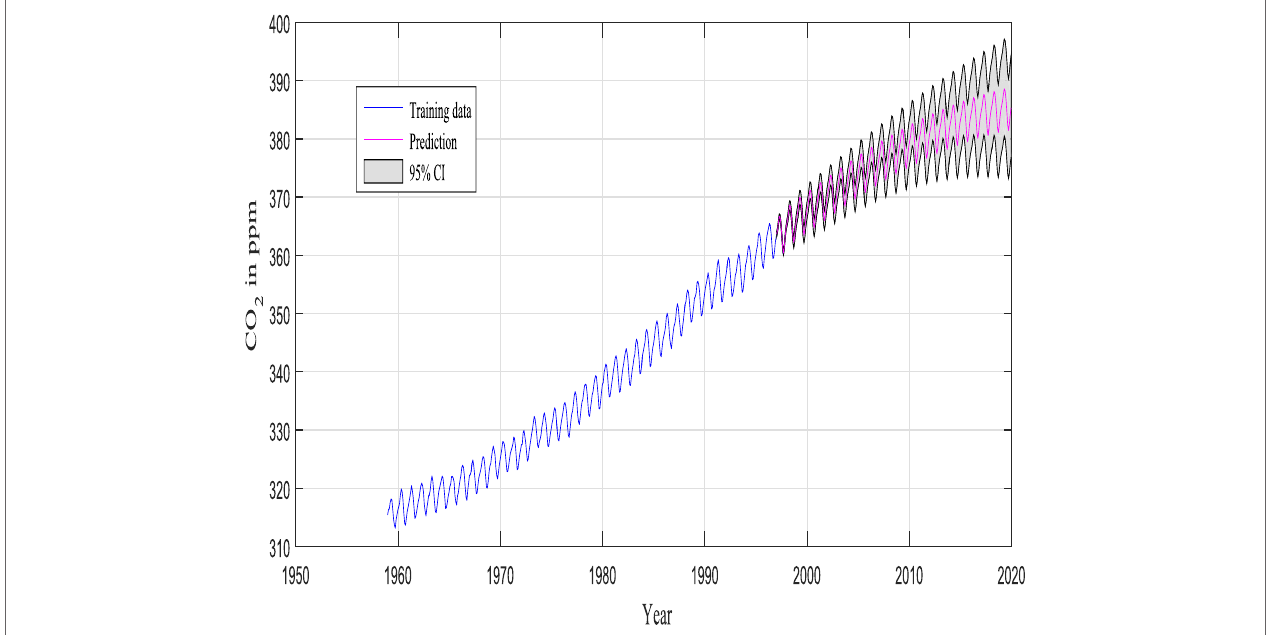
FIGURE 12 | 95% CI obtained from propagating uncertainty in the hyperparameters.